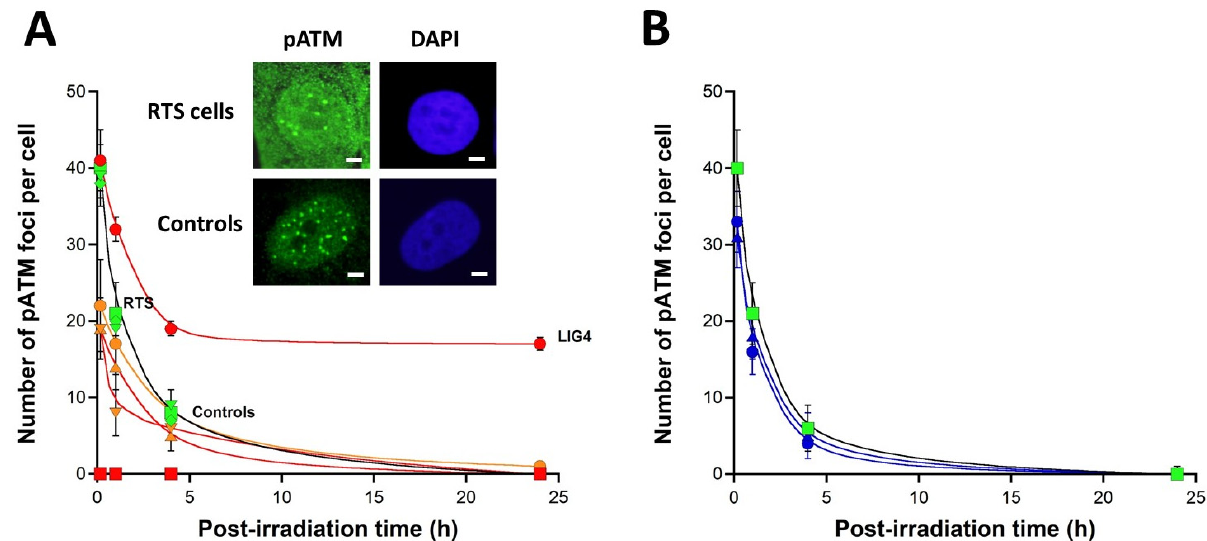
Figure 4. Kinetics of pATM foci in RTS fibroblasts. Anti-pATM immunofluorescence was applied to ( A ): the radioresistant controls (green symbols: 1BR3, squares; MRC5, diamonds; Hs27, inverted triangles), the hyper-radiosensitive LIG4 -mutated 180BR (red circles) and the three RTS (orange symbols: 81CLB, circles; AG17524, triangles; AG18371 inverted triangles) fibroblast cell lines and to ( B ): 2 fibroblast cell lines from parents of RTS patients (blue symbols: AG18466, circles and AG18373, triangles) in addition to the radioresistant 1BR3 controls (green squares). The number of pATM foci was plotted against the post-irradiation time. Each plot represents the mean ± SEM of three replicates. For clarity, only the 1BR3 data, the 81CLB, AG17524, and AG18371 data, the 180BR, and the AG18466 and AG18373 data were fitted. Data were fitted to the Bodgi’s formula [58]. The insert in panel ( A ) shows a representative example of pATM foci assessed 1 h post-irradiation in one RTS fibroblast cell line (81CLB) and one radioresistant control (1BR3), with the corresponding DAPI counterstaining. The white bar corresponds to 3 µm.